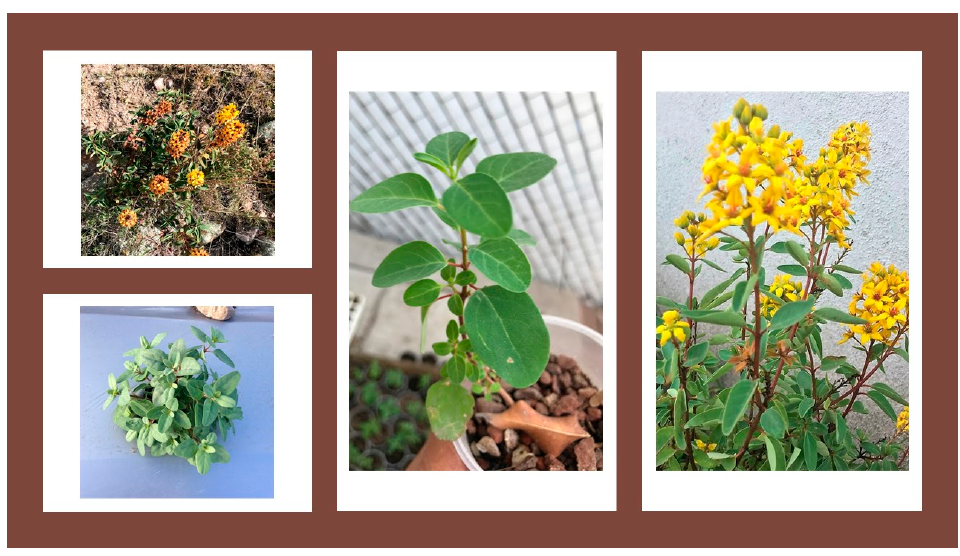
Figure 1. Galphimia glauca at different stages of development (photo courtesy of Ashutosh